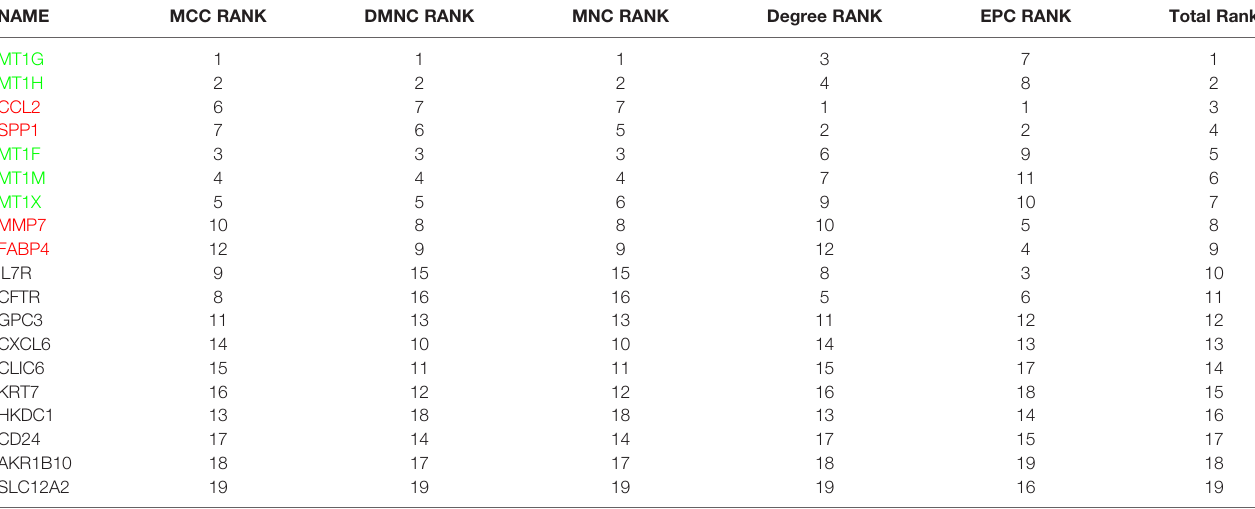
TABLE 3 | Genes fi ltered by Cytoscape software (CytoHubba plugin and MCODE